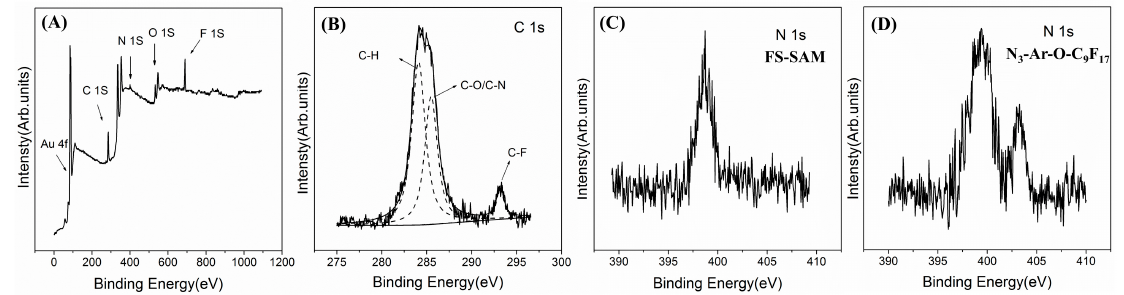
Figure 1. X-ray photoelectron spectrometry (XPS) wide-scan spectrum ( A ); C 1s core-level spectrum ( B ); and N 1s core-level spectrum ( C ) of the fluorosurfactant self-assembled monolayer (FS-SAM); and XPS N 1s core-level spectrum of N 3 -Ar-O-C 9 F 17 ( D ).